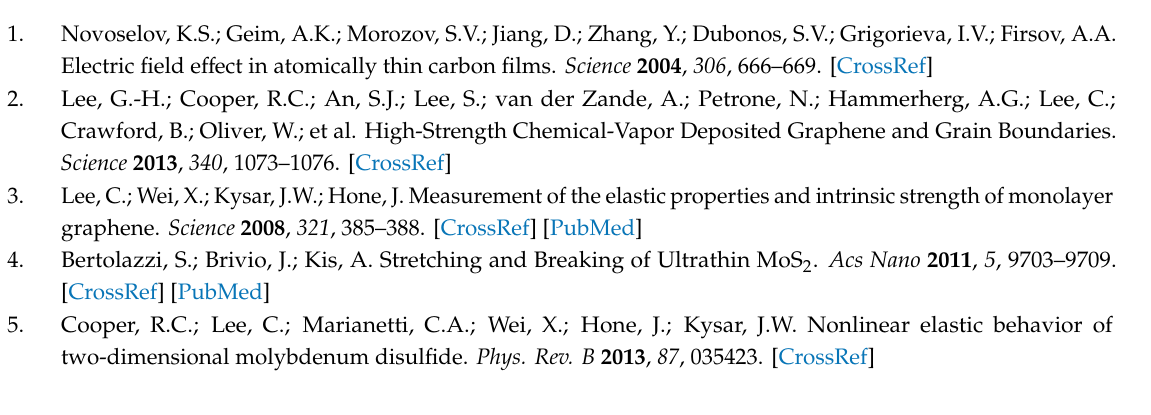
Figure S1: Schematic of two thermostat schemes: (a) Part NVT: the Langevin thermostat is only applied to the MoS 2 atoms close to the fixed region. (b) All NVT: the Langevin thermostat is applied to all free atoms from the MoS 2 layer. Part NVT is adopted in this work. For both schemes, the thermosetting regions in the Pt substrate are the same as that in the main manuscript. (c) The force-depth relations of the MoS 2 / Pt substrate during nano-indentation process using Part NVT and All NVT. (d) The friction-distance curves of the MoS 2 / Pt substrate during nano-scratch process using Part NVT and All NVT. Figure S2: Schematic of indenting points (IP) and scanning lines (SL) on the MoS 2 . Each scanning line passes through a corresponding indenting point, which is indicated by red